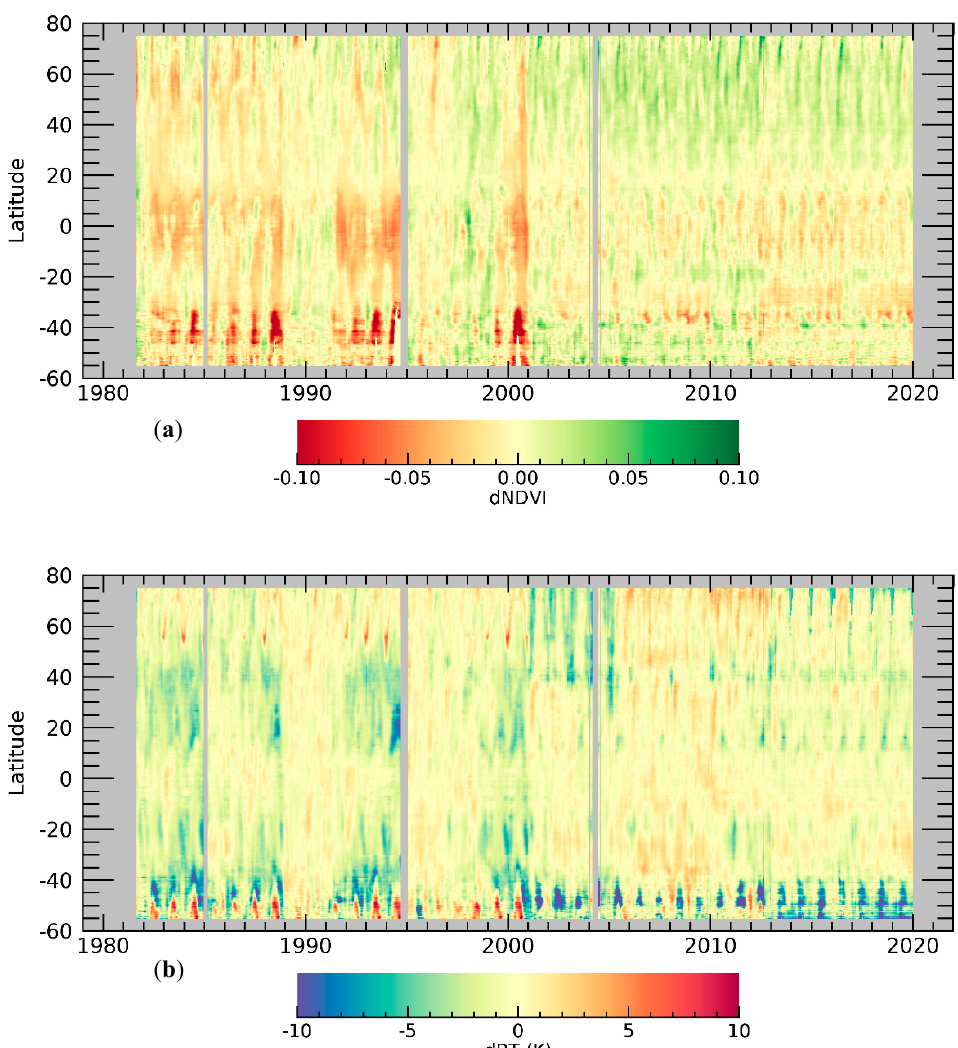
Figure 1. Zonal (4 km resolution) di ff erence between smoothed ( a ) Normalized Di ff erential Vegetation Index (NDVI), ( b ) Brightness Temperature (BT) products and their averaged values from benchmark years: 1989, 1990, and 1995–1997, when there were no serious volcanoes, and other noises were least contaminated. The striking bars indicate data missing in years 1985, 1994–1995, and 2004. Note data from 1981 to 2012 are derived from Advanced Very High Resolution Radiometer (AVHRR), and 2013 to 2019 data are from Visible Infrared Imaging Radiometer Suite (VIIRS). Vegetated land pixels cover from south 55 to north 75, and in each week, valid values in the same latitude are averaged.